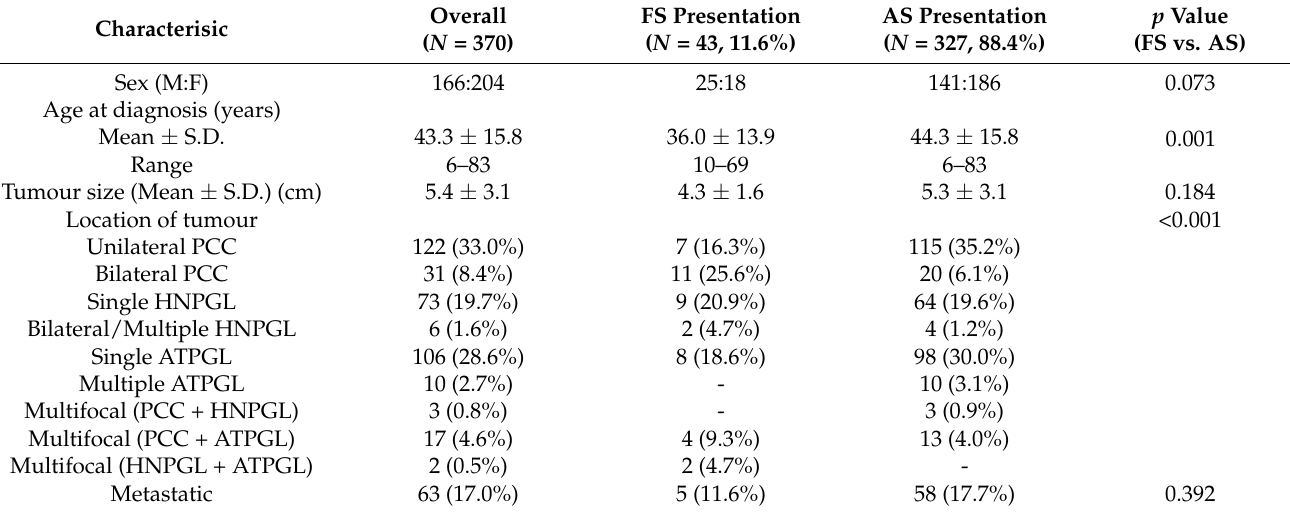
Table 1. Clinical characteristics of patients with PPGL in the